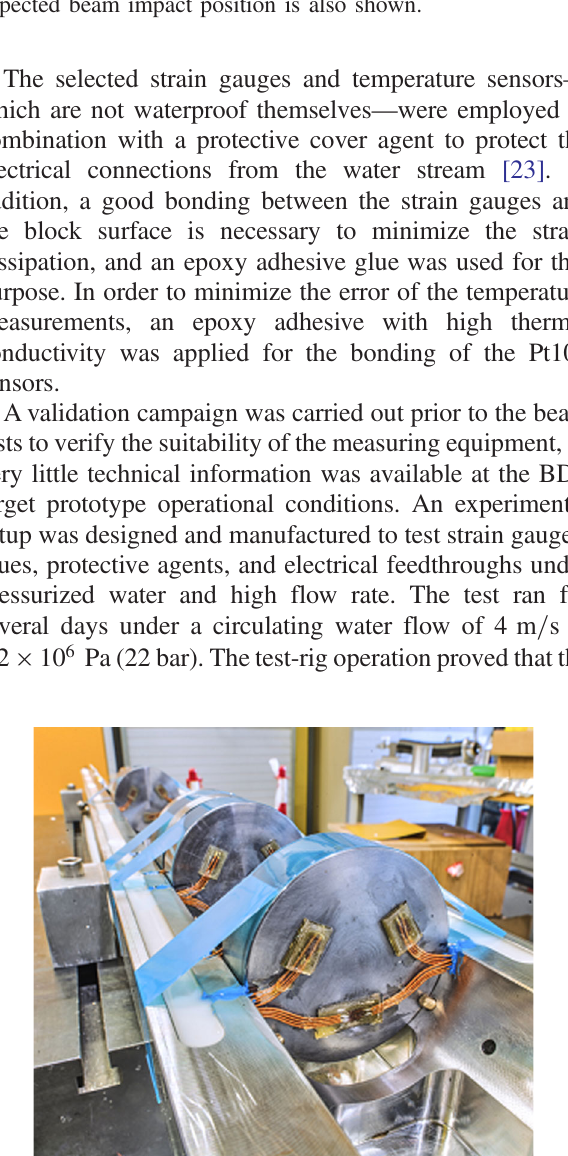
FIG. 12. Biaxial strain gauges for radial (R) and transversal (T) measurements in three positions (01, 02 and 03) and temperature sensors (Pt100) in two positions. Design for the upstream (left) and downstream (right) faces of blocks 4, 8, 9 and 14. The expected beam impact position is also shown.